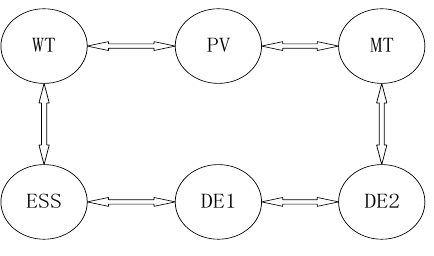
Figure 8. DG communication topology.